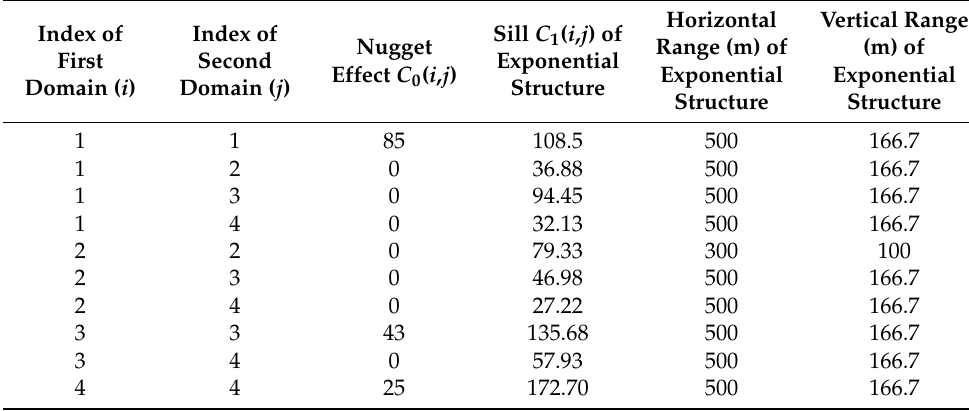
Figure 5. Experimental (crosses) and modeled (solid lines) direct and cross-covariances for iron grade data in D1 to D5, calculated along the horizontal (black) and vertical (blue) directions. The cross-covariances between D5 and the other domains are identically zero and are not represented. Table 3. Parameters of fitted multivariate exponential model (D1 to D4).